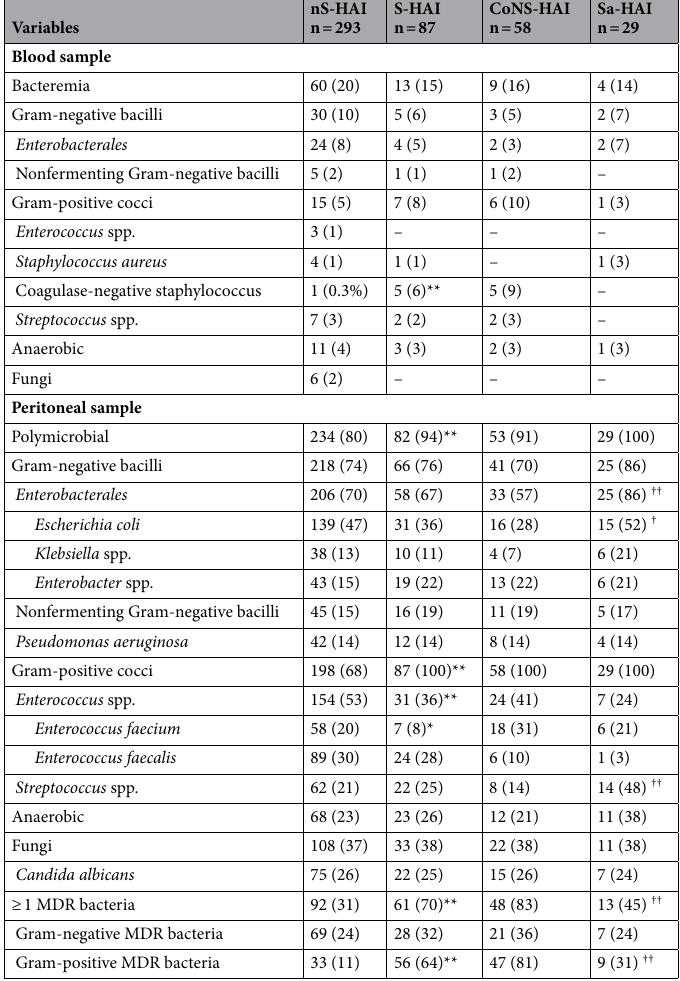
Table 2. Microbiological results of the four groups of patients with HAIs. nS-HAI infection without staphylococci peritoneal culture, S-HAI infection with staphylococci positive peritoneal cultures, Sa-HAI infection with Staphylococcus aureus positive peritoneal culture, CoNS-HAI infection with a coagulase-negative staphylococcus positive peritoneal culture, MDR multidrug-resistant. No missing data. *p < 0.05 and **p < 0.01 between the nS-HAI and S-HAI groups; † p < 0.05 and †† p < 0.01 between the CoNS-HAI and SA-HAI